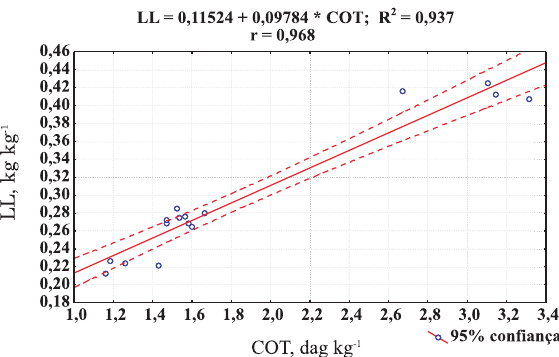
Figura 2. Relação entre o limite de liquidez (LL) e o carbono orgânico total (COT) do solo, na profundidade de 0– 0,20